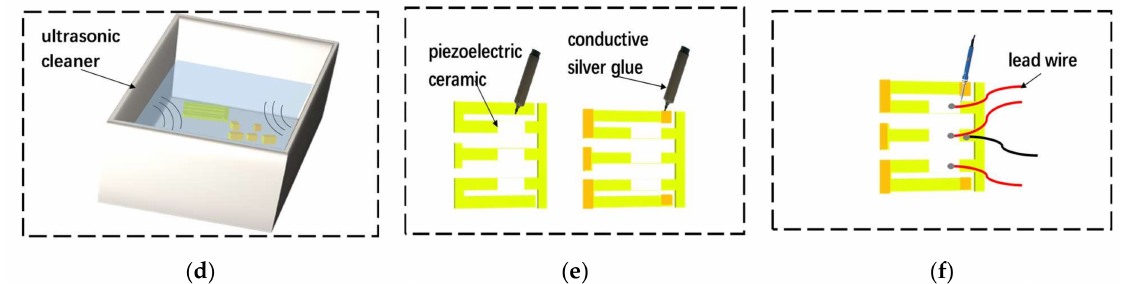
Figure 2. The fabrication processes of the proposed PEH. ( a ) Laser cutting; ( b ) Surface heating; ( c ) Surface polishing; ( d ) Surface cleaning; ( e ) Bonding piezoelectric ceramics and proof masses; ( f ) Wire